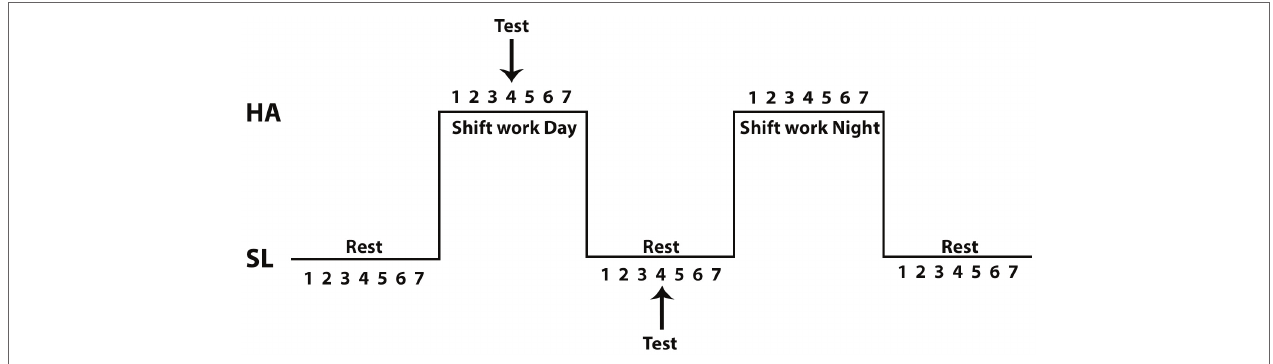
FIGURE 1 | A model of chronic intermittent hypobaric hypoxia exposure. Arrows show day when the evaluations were performed during the shiftwork day at high altitude or sea